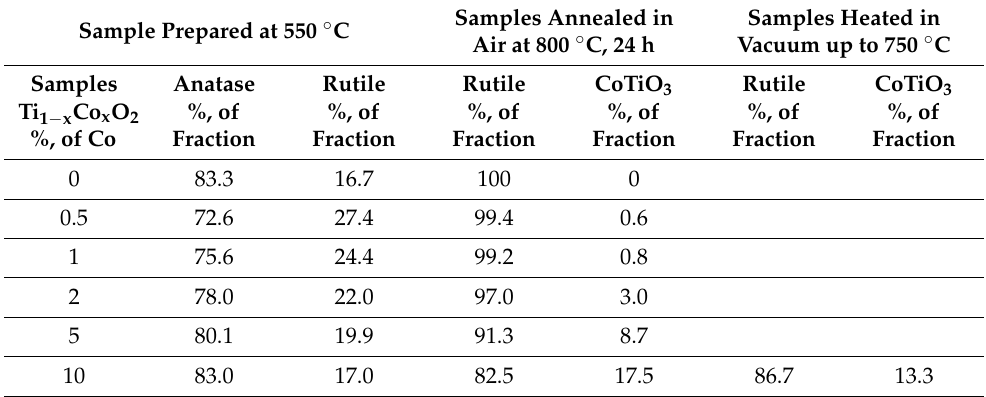
Table 2. XRD analysis of the TiO 2 :Co samples prepared at 550 ◦ C, annealed at 800 ◦ C during 24 h and heated in vacuum up to 750 ◦